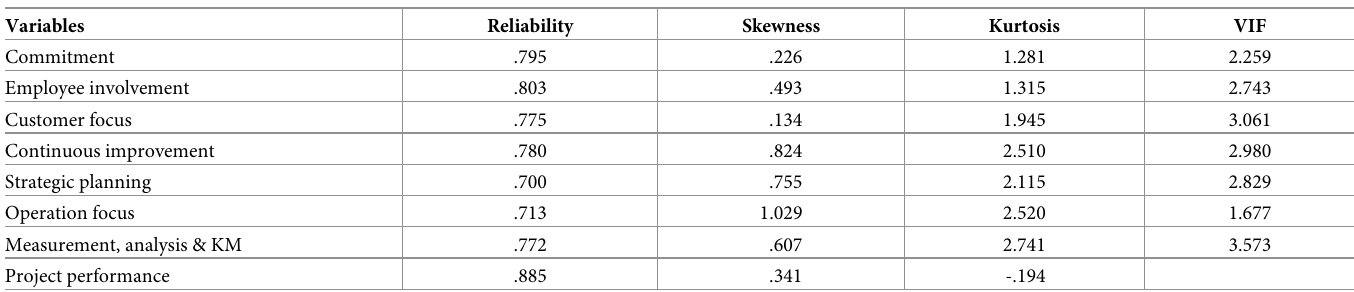
Table 2. Cronbach alpha and normality test summary.